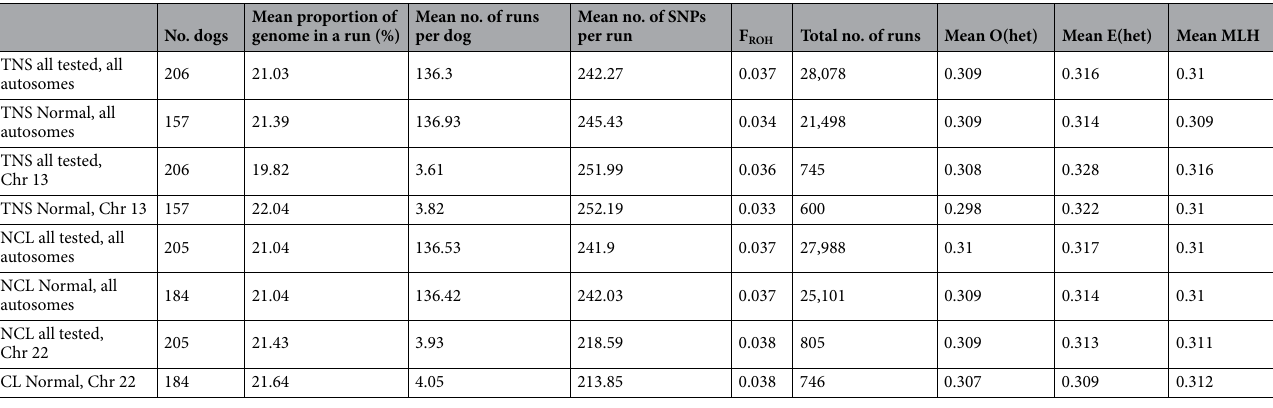
Table 5. Summary of runs of homozygosity (> 1 Mb), mean observed (O(het)) and expected heterozygosity (E(het)) and multi-locus heterozygosity (MLH) for all dogs tested for TNS and CL to compare with dogs normal for TNS and CL across all autosomes and across the chromosomes where the mutations are